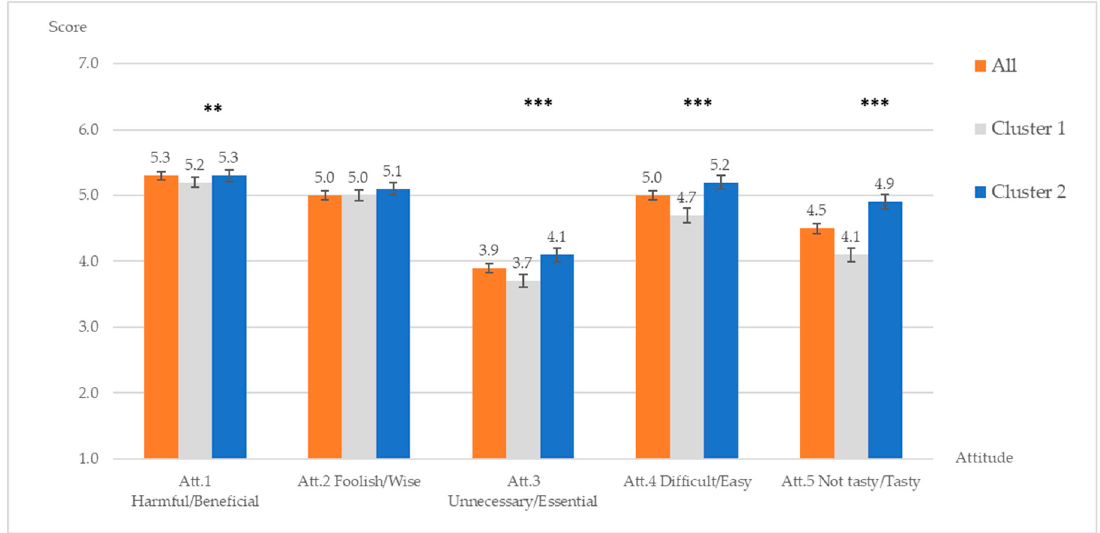
Figure 2. Attitude towards including whole grain pasta in the diet over the next month in the sample, Cluster 1 (Uninvolved) and Cluster 2 (health-conscious). Results from the Mann–Whitney U test between 2 clusters: ** significant at the 0.05 level, *** significant at the 0.01 level.